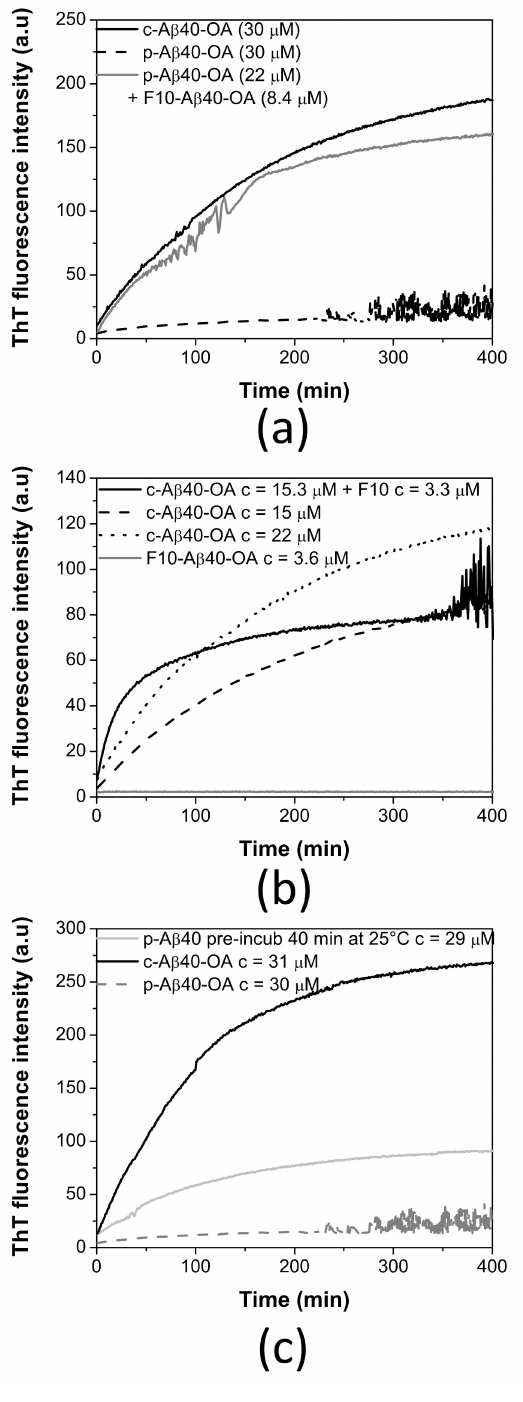
Figure 4. ( a ) Effect of F10-A β 40-OA addition on freshly prepared p-A β 40-OA ThT aggregation kinetics. ( b ) Aggregation time dependence of F10-A β 40-OA at 3.6 µ M (grey line), c-A β 40-OA oligomers at 15 µ M (dashed black line), 22 µ M (dotted black line), and of c-A β 40-OA (15 µ M) enriched with 3.3 µ M F10-A β 40-OA followed by ThT fluorescence. ( c ) Comparison of the ThT aggregation kinetics at 37 ◦ C of p-A β 40-OA at 30 µ M (dotted grey line), p-A β 40-OA at 29 µ M pre-incubated at 25 ◦ C for 40 min (continuous grey line), and c-A β 40-OA at 31 µ M (black